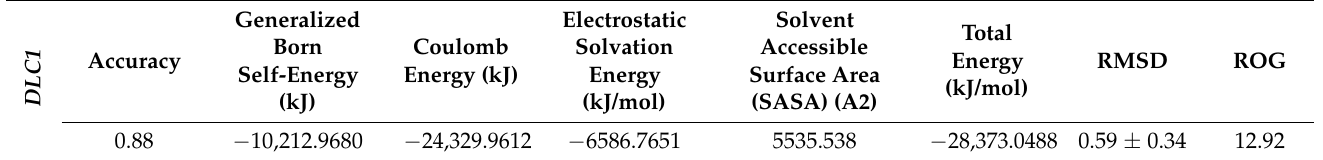
Figure 4. Vacuum electrostatic and MMGBSA potential of DLC1: ( a ) vacuum electrostatics before MD simulation and ( b ) vacuum electrostatics after MD simulation. The light blue-colored tertiary structure represents the refined structure of DLC1 after the MD simulation, along with the MMGBSA electrostatic potential in an APBS map. Table 5. Energy landscape and electrostatic computations calculated after MD simulation for